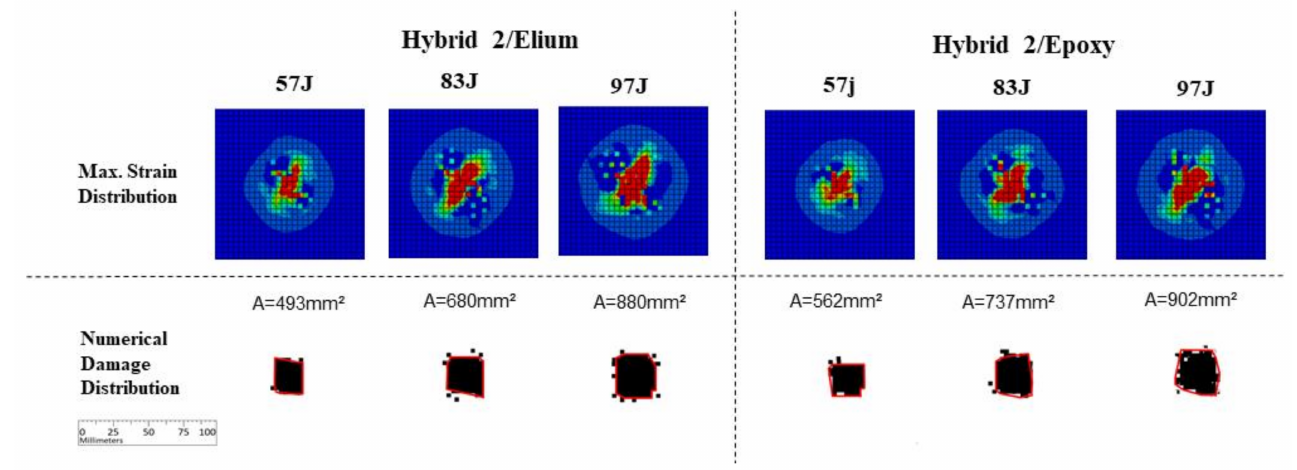
Figure 20. Numerical results for Hybrid 2 carbon/glass fibers specimens.